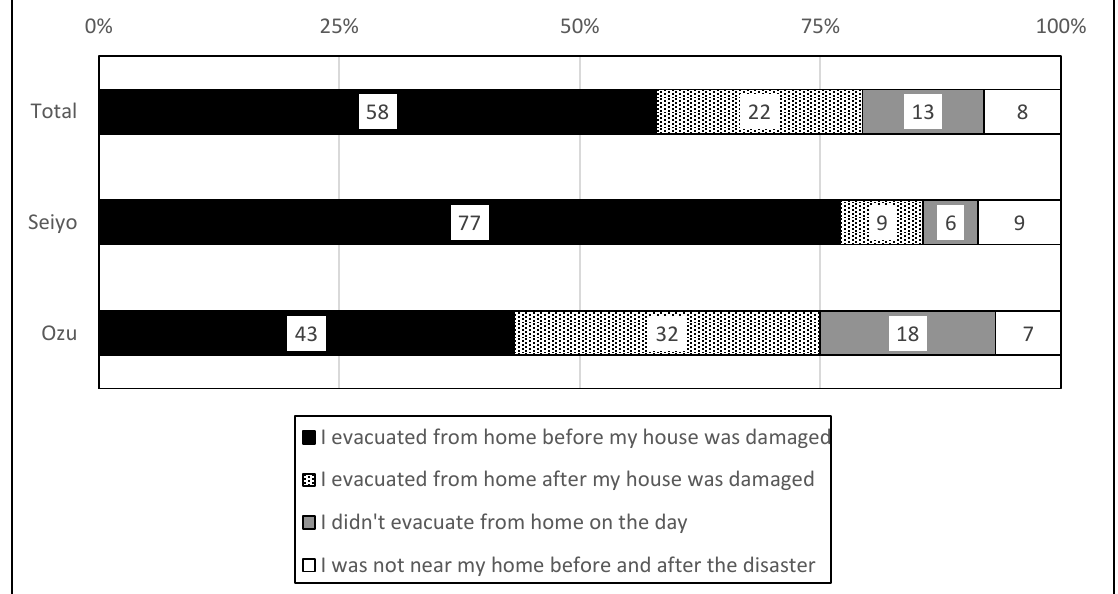
Table 5. Variables related to early evacuation (1) (logistic regression analysis).